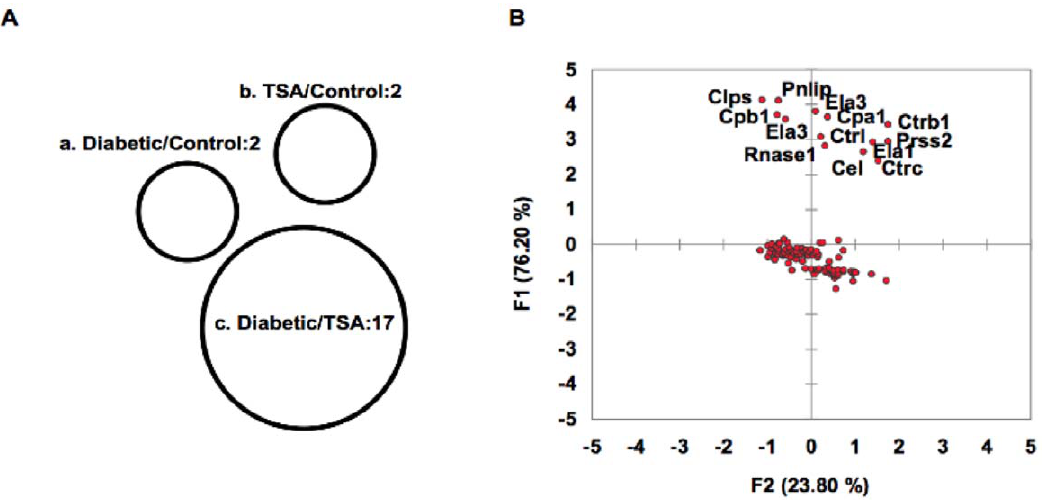
Figure 2. Genome wide expression profiling of splenocytes. ( A ) Differentially expressed 164 genes obtained from the microarray analysis were further analyzed. The area-proportional Venn diagram depicts 17 genes that were over-expressed in diabetic mice in comparison to TSA-treated mice. ( B ) Principal component analysis of diabetic/TSA-treated (F1) group indicates significant up-regulation of the same set of genes ( Clps, Pnlip, Cpb1, Ela3, Cpa1, Ctrb1, Ctrl, Prrs2, Rnase1, Ela1, Cel, and Ctrc ) depicted in Venn diagram (group c in A ).